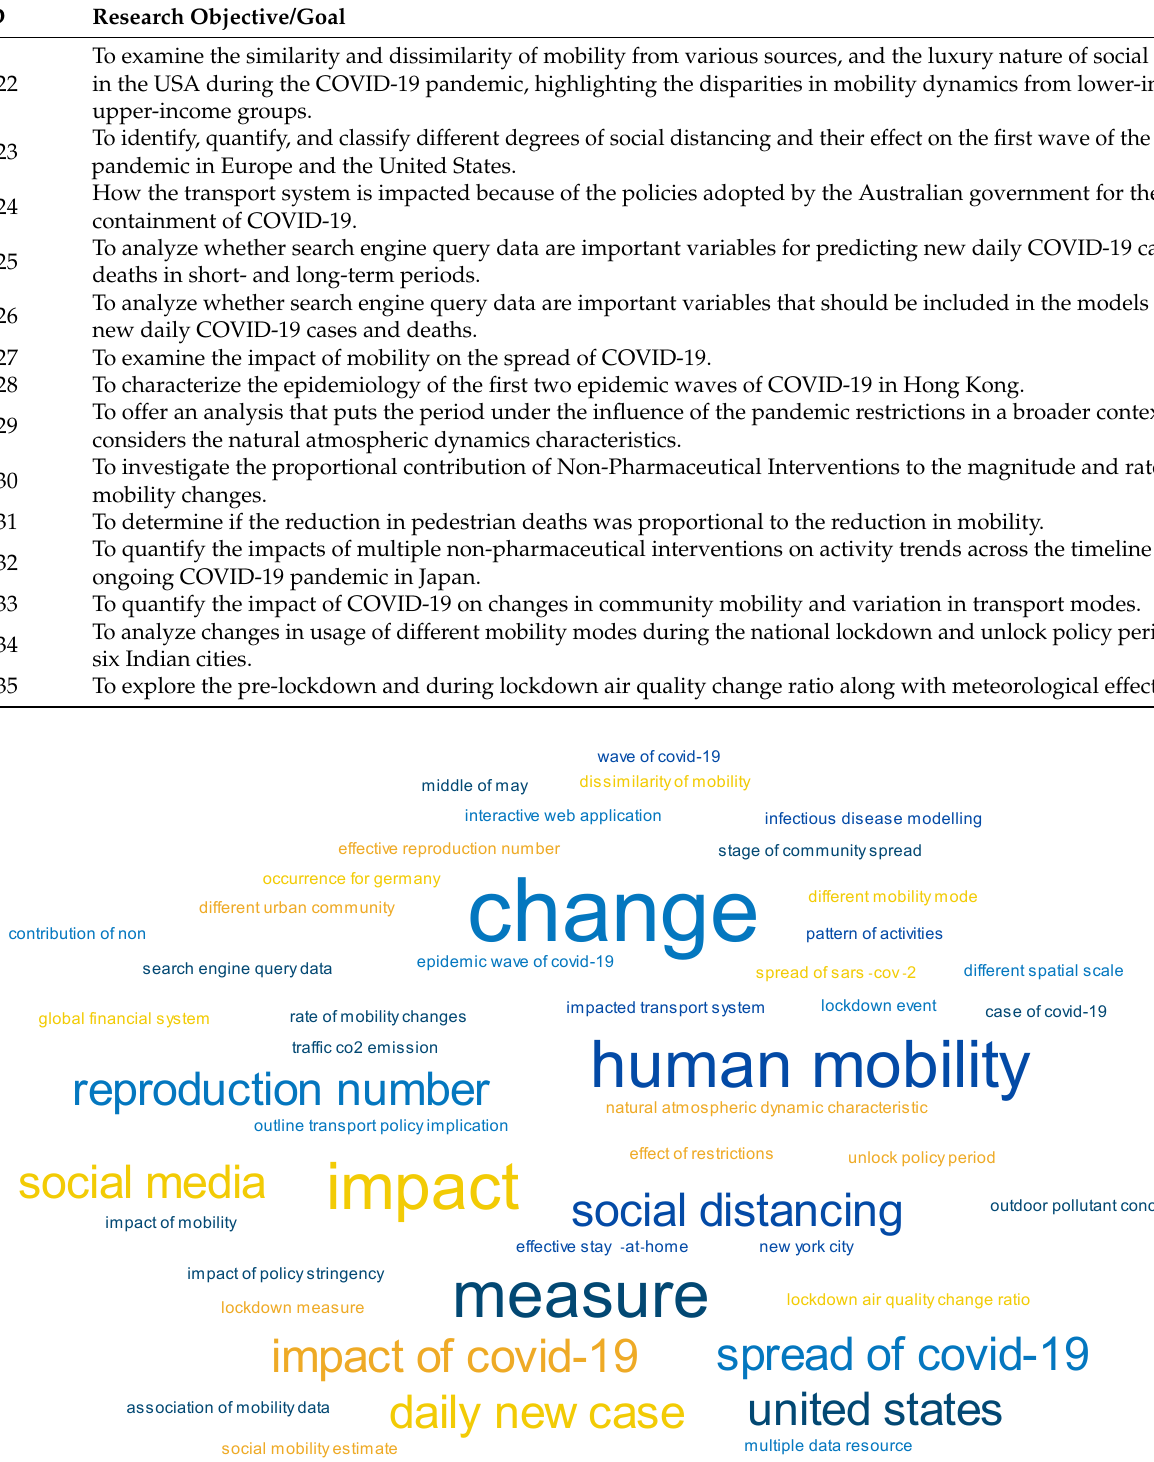
Figure 2. Word cloud of the most important objective and goals based on Table 2.